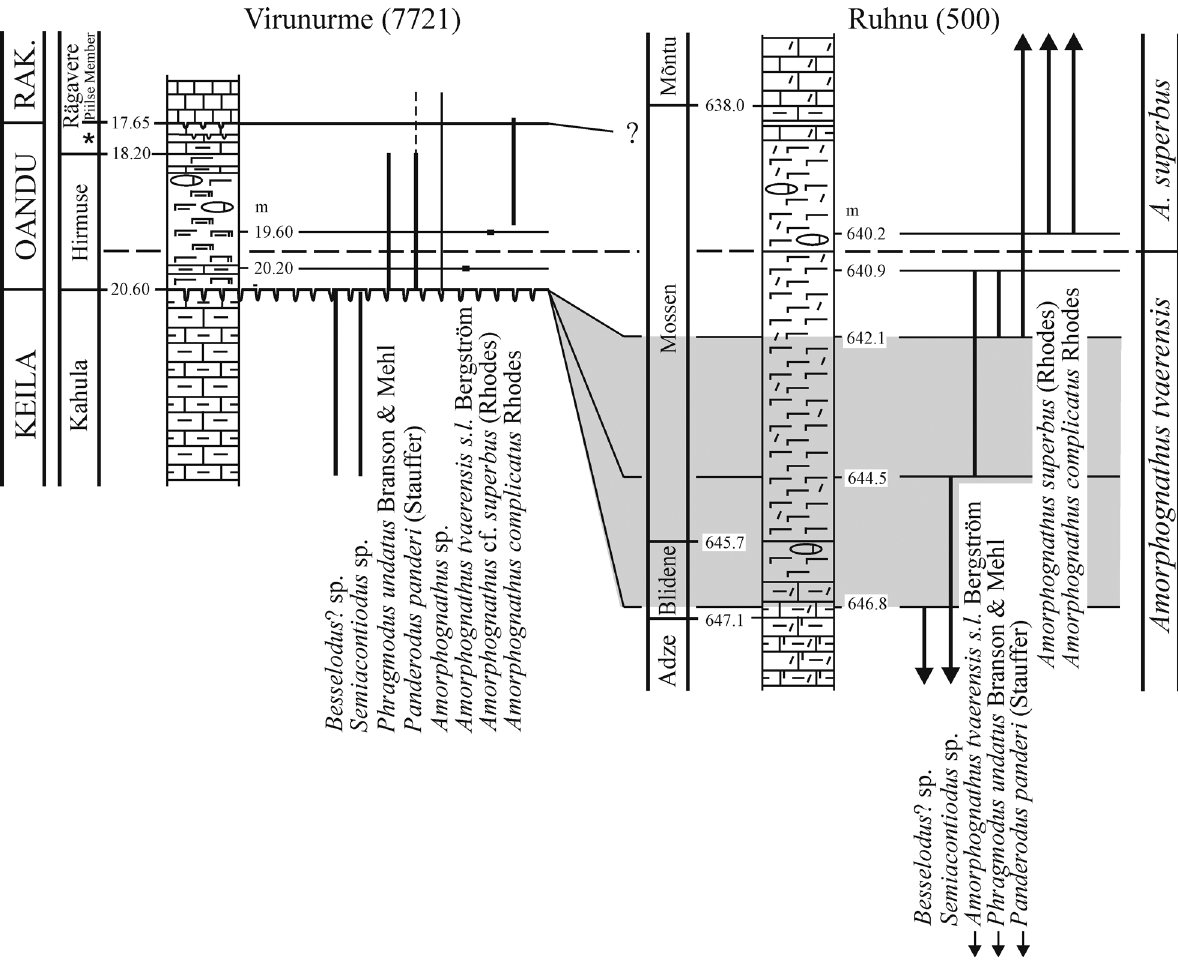
Fig. 8. Conodont-based correlation of the Virunurme (7721) and Ruhnu (500) core sections. The lithological log of Ruhnu (500) is modified from Põldvere (2003). For the lithological legend of sections refer to Fig. 3. Stages are indicated on the left-hand side of the figure and conodont zones on the right-hand side. In both sections, from left to right: formation (* in the lower part of the Rägavere Formation indicates the interval of the Tõrremägi Member); depth of the boundaries of lithological units; lithological log; depth of the appearance and/or disappearance levels of taxa (indicated only when these levels do not coincide with the unit boundaries); generalized distribution of selected conodonts. The arrows at the ends of distribution lines indicate that these taxa occur also below and/or above the studied interval. ‘?’ at the end of the line marking the boundary between the Oandu and Rakvere stages in the Virunurme (7721) core section means that the position of this boundary in the Ruhnu (500) core section is not known. The strata corresponding to the grey interval in the Ruhnu (500) core section are missing in the Virunurme (7721) core section (correspond to the gap at the lower boundary of the Oandu